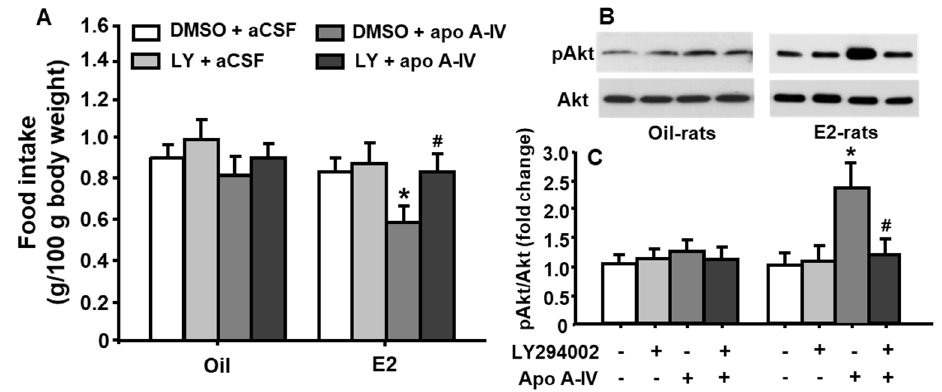
Figure 5. Central apoA-IV (0.5 µg) administration resulted in significant inhibition of food intake, and significant increase of Akt phosphorylation in the NTS of E2-treated OVX rats. These effects were attenuated by LY294002. ( A ) Changes in food intake after apo A-IV or vehicle (aCSF) for 45 min